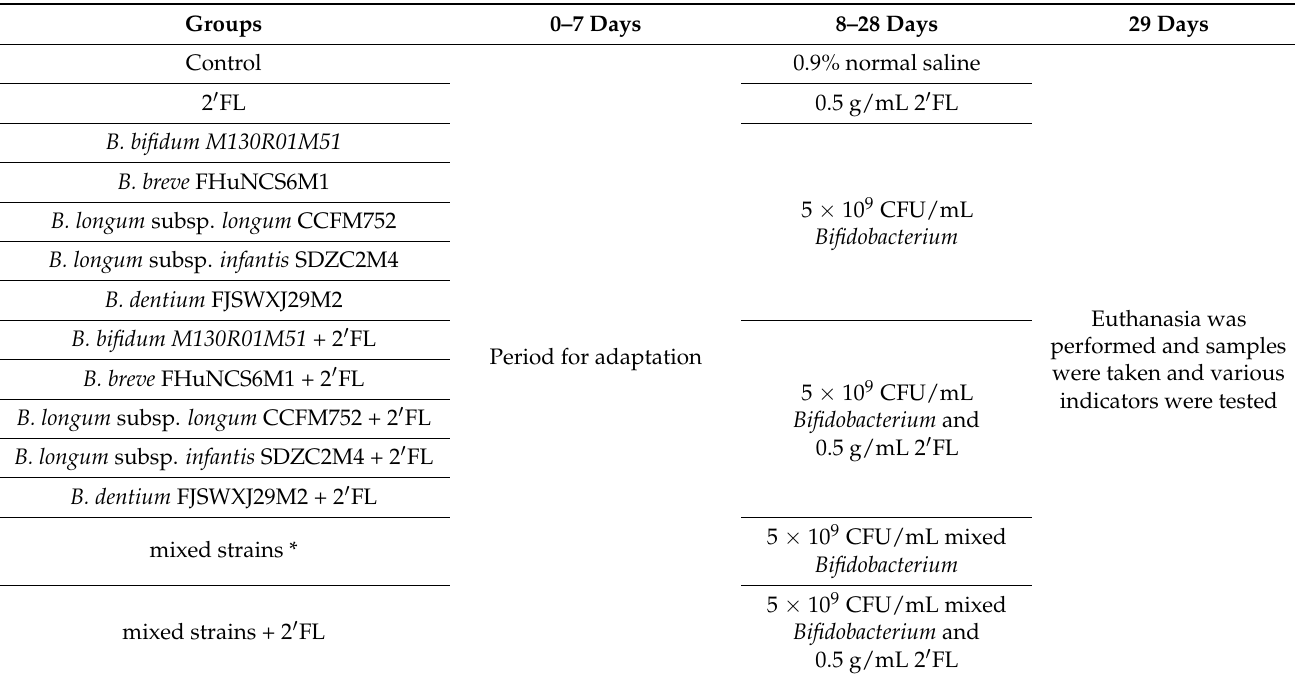
Table 1. Groups and schedules of the animal